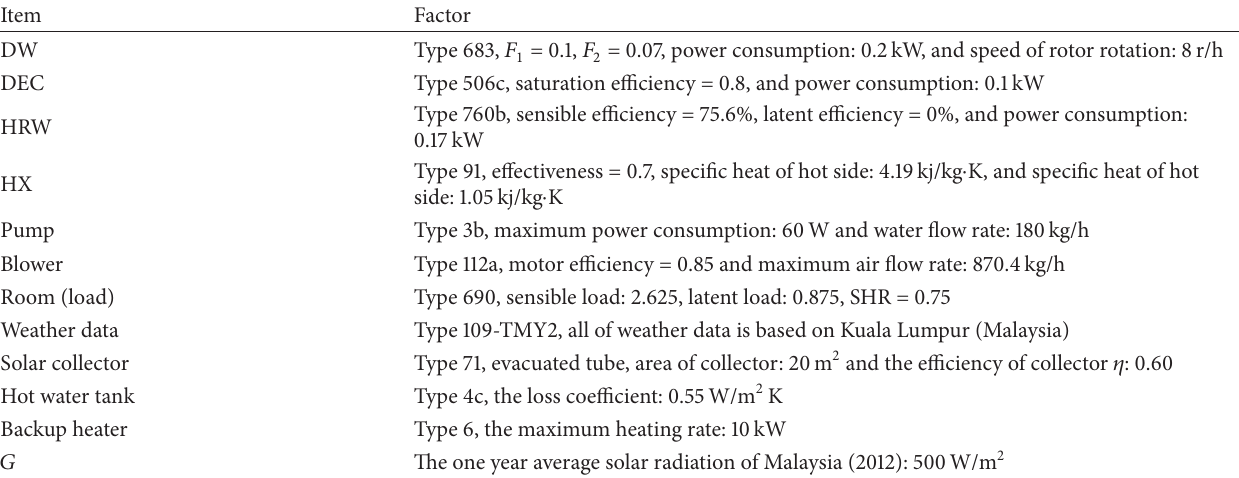
Table 1: Specific assumptions used in simulation.